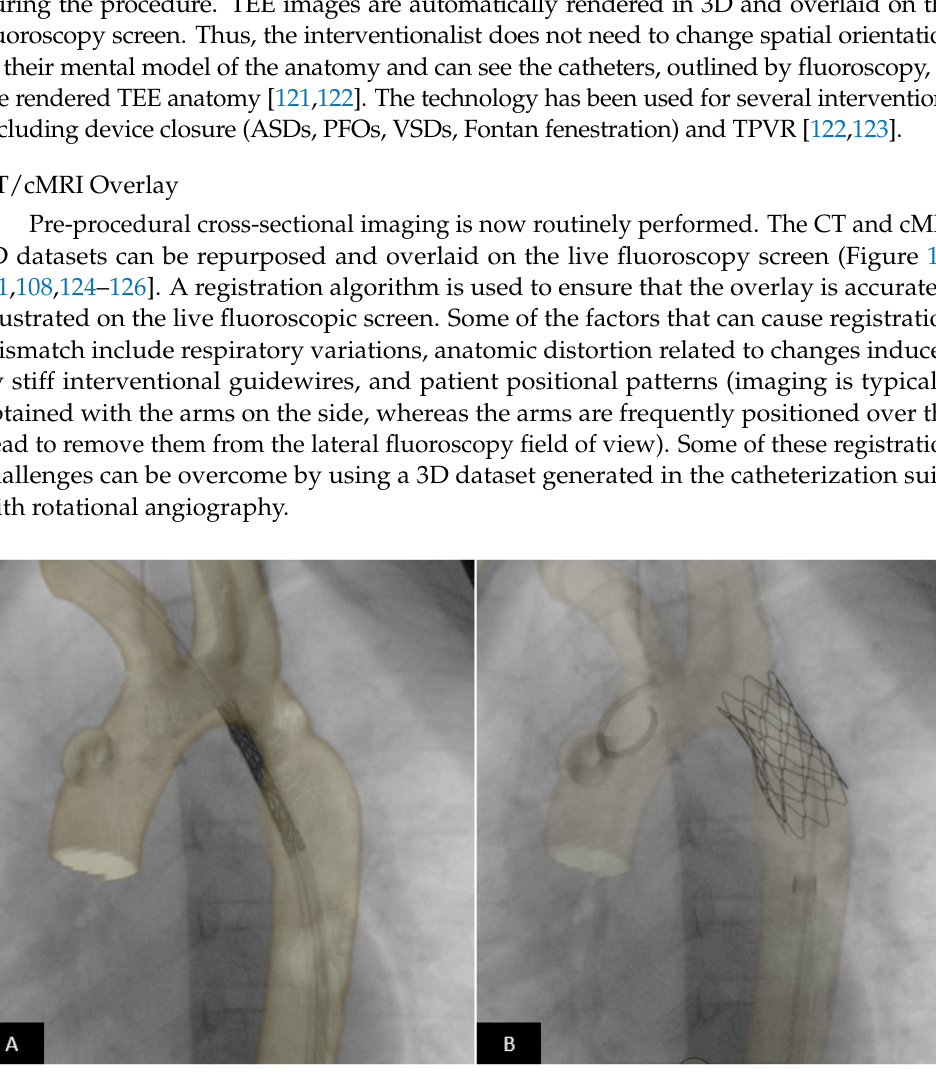
Figure 15. CT image overlay using VesselNavigator™ System (Philips Healthcare) for coarctation stenting. Pre-procedural CT dataset is overlaid on live fluoroscopy in the catheterization suite and used as a roadmap using image registration. ( A ) In real time the stent is positioned across the coarctation segment using the roadmap. Precise placement of the stent can be performed without repeated positioning angiograms based on the overlay image. ( B ) The stent is in excellent position completely covering the coarctation segment and positioned such that the origin of the left subclavian is not